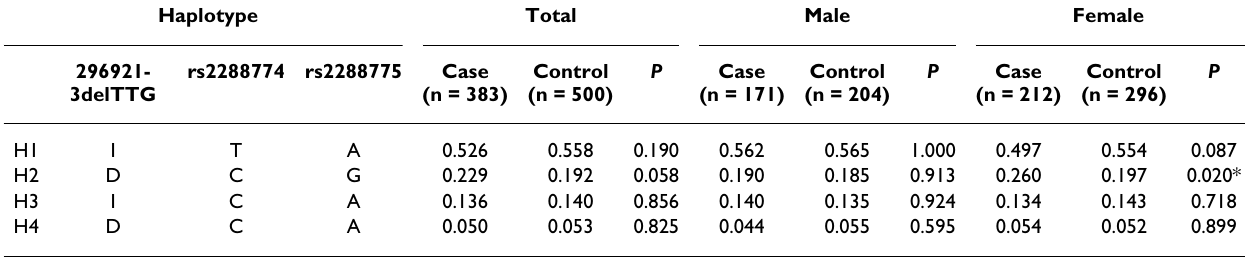
Table 5: Haplotype analysis in patients with essential hypertension and control participants